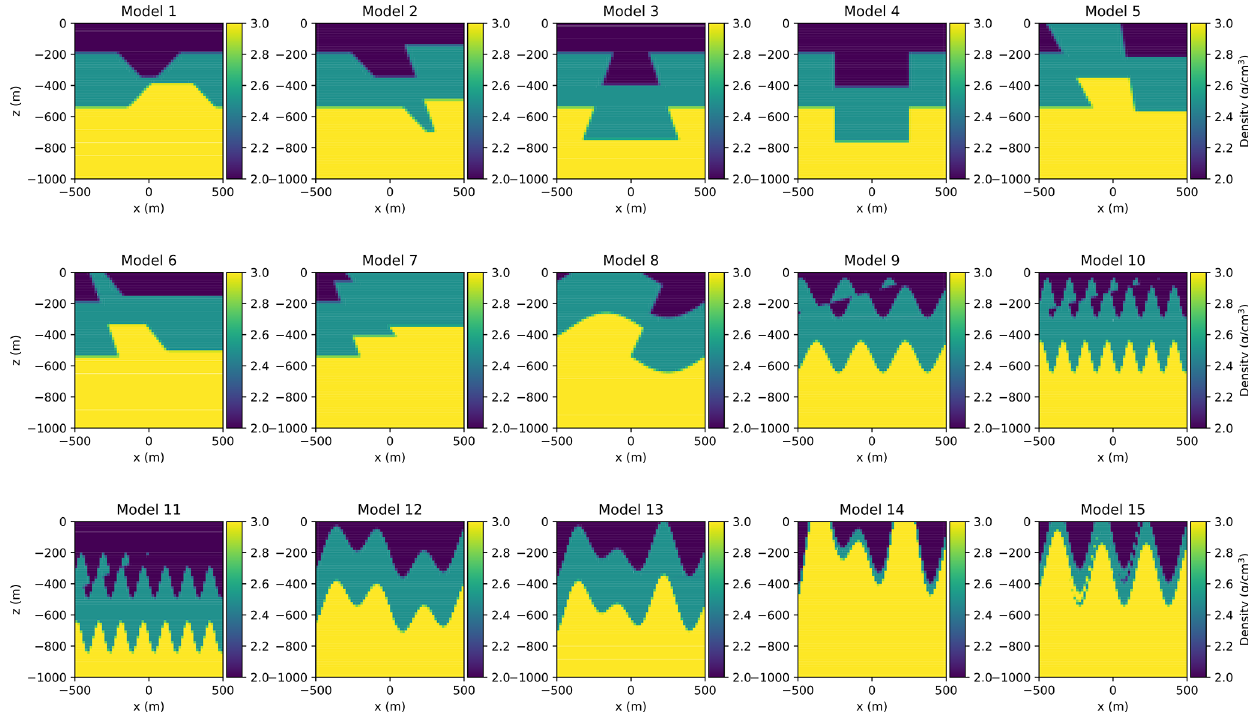
Figure 5. Voxelized final states of all models in the suite, displaying 3-D geology in cross